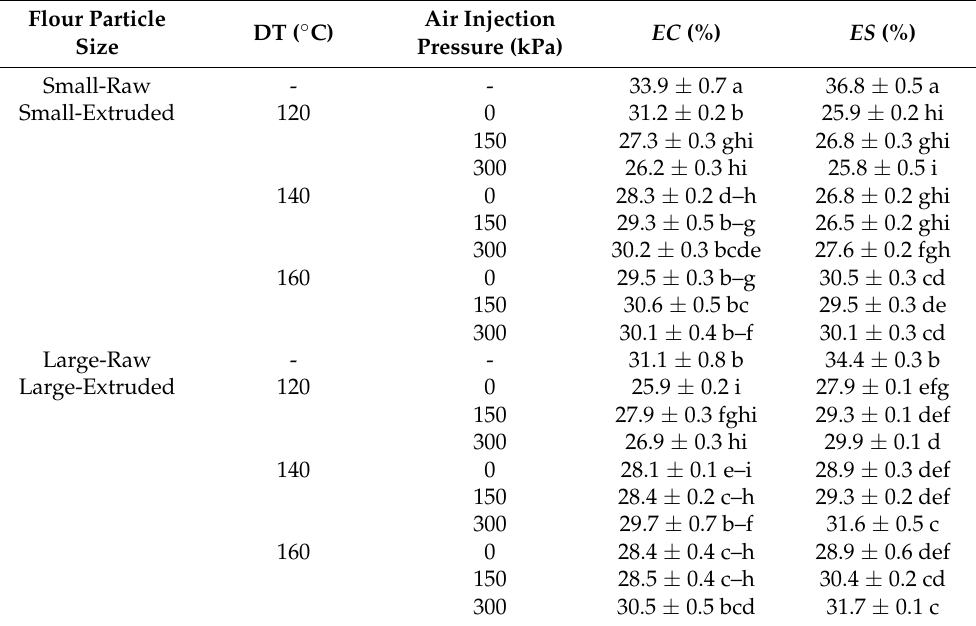
Table 3. Emulsion capacity ( EC ) and emulsion stability ( ES ) of raw and extruded yellow pea flours as a function of flour particle size, die temperature (DT) and air injection pressure. Flour Particle DT ( ◦ Size